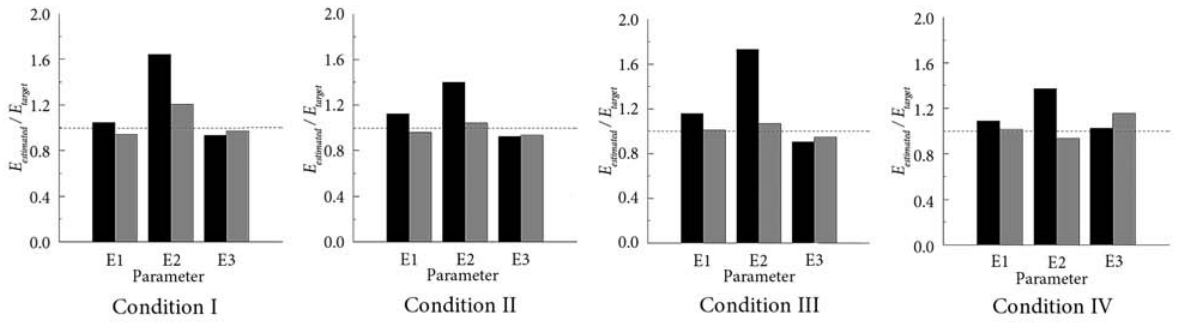
Fig. 9. Example of estimation results for conditions I, II, III, and IV with modeling errors of 5% for bedrock boundary case: – conventional NN; – proposed